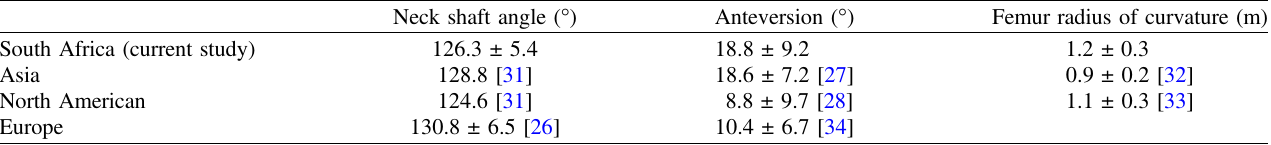
Table 4. Difference between measurements for geographical